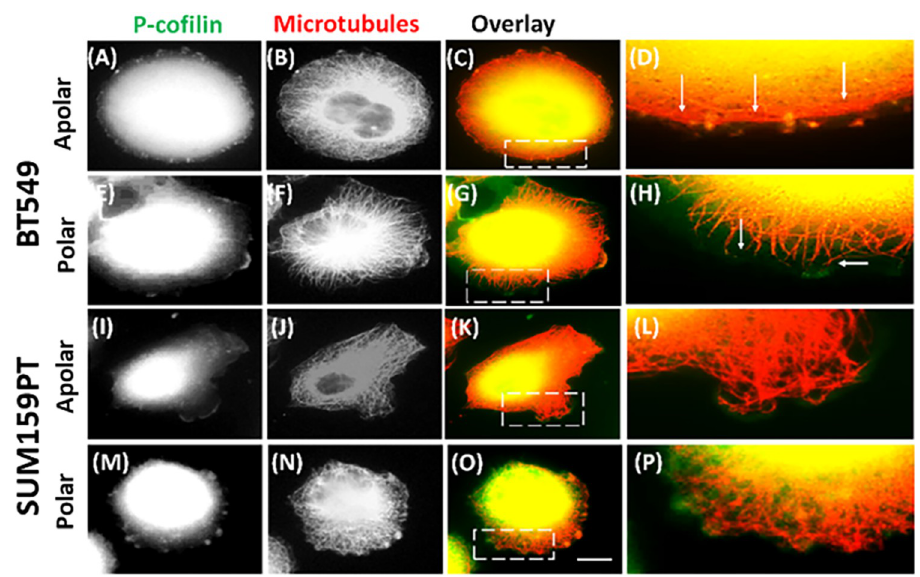
Fig 5. Microtubules contribute to localization of p-cofilin at the leading edge of BT549 and MDA-MB-453 cells. Representative images showing localization of p-cofilin in apolar BT549 cells (A), polar BT549 cells (E), apolar SUM159PT cells (I), polar SUM159PT cells (M), microtubules (B, F, J, N, respectively), and overlay (C, G, K, O, respectively). Images D, H, L, P are enlarged images of the dashed white boxes in C, G, K, O, respectively. White arrows in images D and H indicate orientation of microtubules at the leading edge. MDA-MB-453 cells (not shown) have similar distributions to BT549 cells. Scale bar: 10 μ